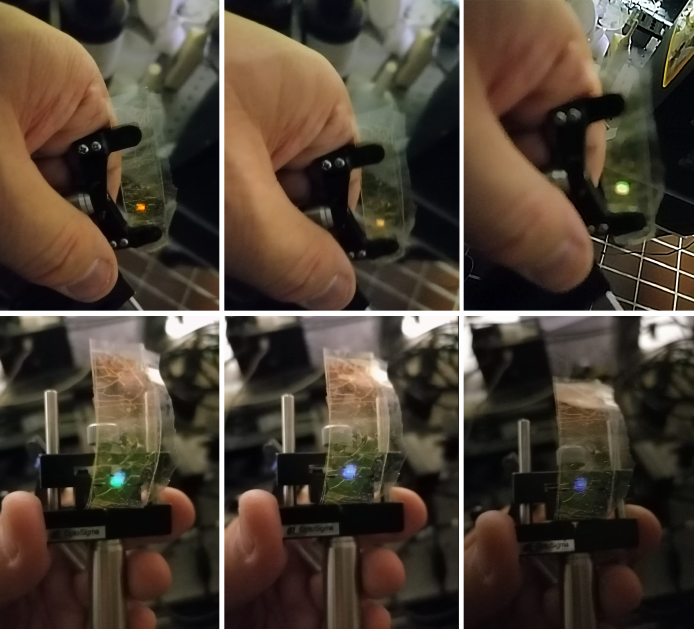
Figure 7. A typical free-standing sample, the colours of which change by altering the angle of vision with respect to the ambient light. Colours shown range from deep red to deep